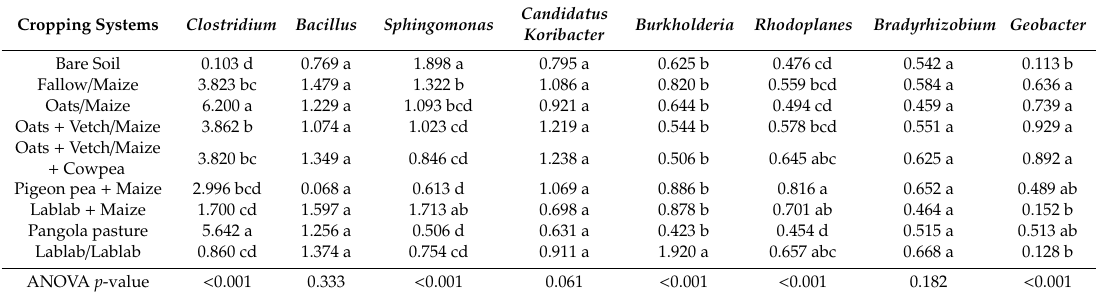
Table 4. Di ff erences in the relative abundances of the eight most abundant genera (where mean relative abundance for a given genus in a given treatment was > 0.5%). Lower-case letters denote statistically significant di ff erences (where ANOVA p ≤ 0.001).